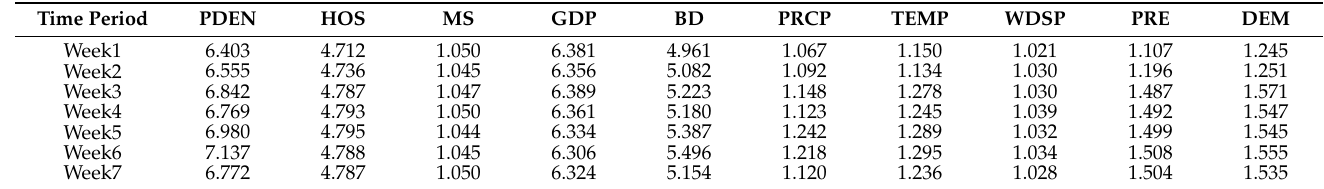
Table 9. Variance Inflation Factor (VIF) of exploratory variables in mainland China.